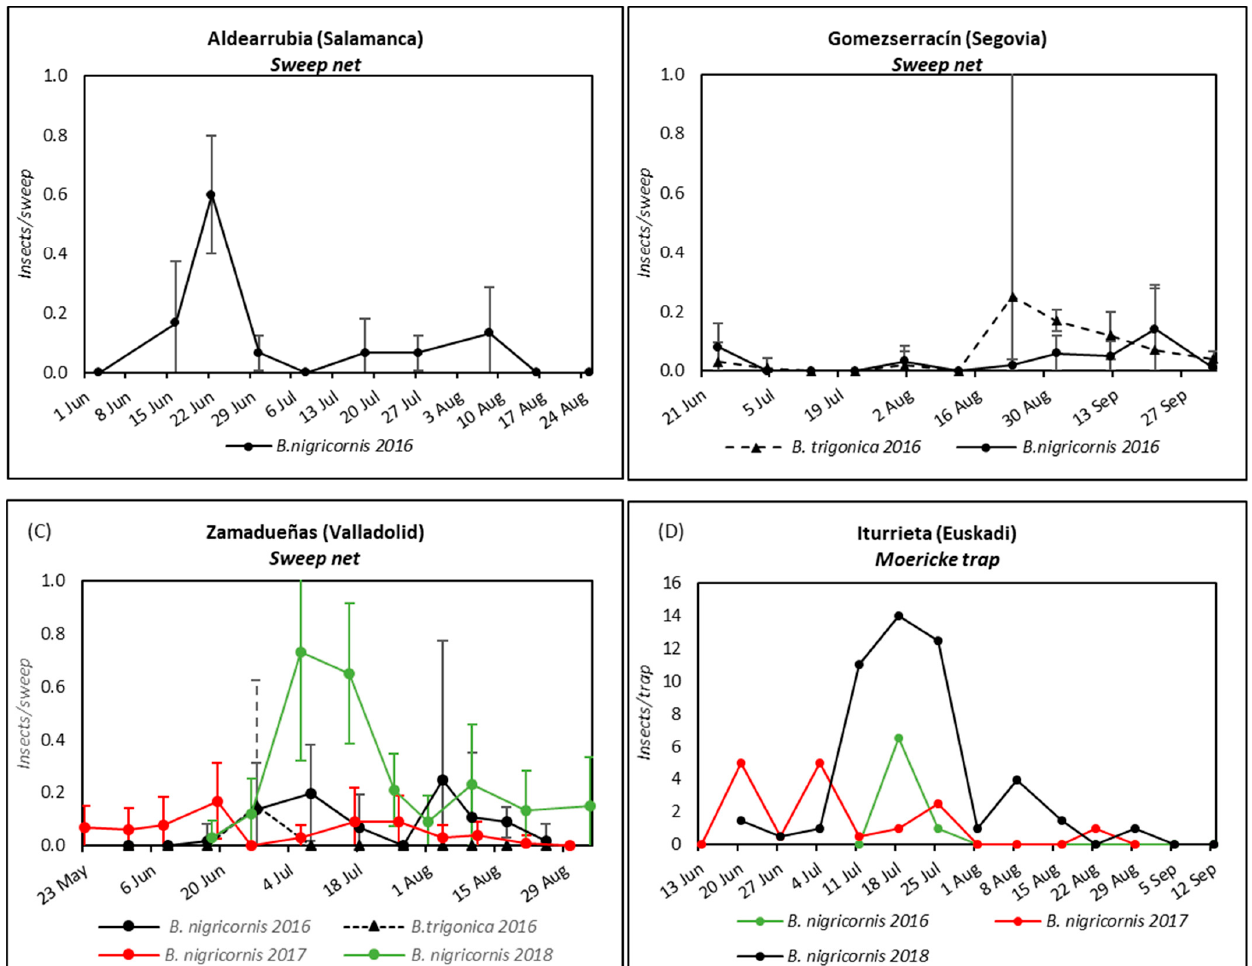
Figure 2. Mean number of psyllids collected per sweep net sampling in ( A ) Aldearrubia (Sala- manca), ( B ) Gomezserracín (Segovia) and in ( C ) Zamadueñas (Valladolid); and per yellow ( B ) Gomezserrac í n (Segovia) and in ( C ) Zamadueñas (Valladolid); and per yellow Moericke water Moericke water trap in ( D ) Iturrieta (Araba, Euskadi). trap in ( D ) Iturrieta (Araba,